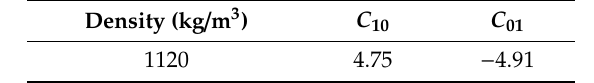
Table 1. The parameters of the biological soft tissue used in the